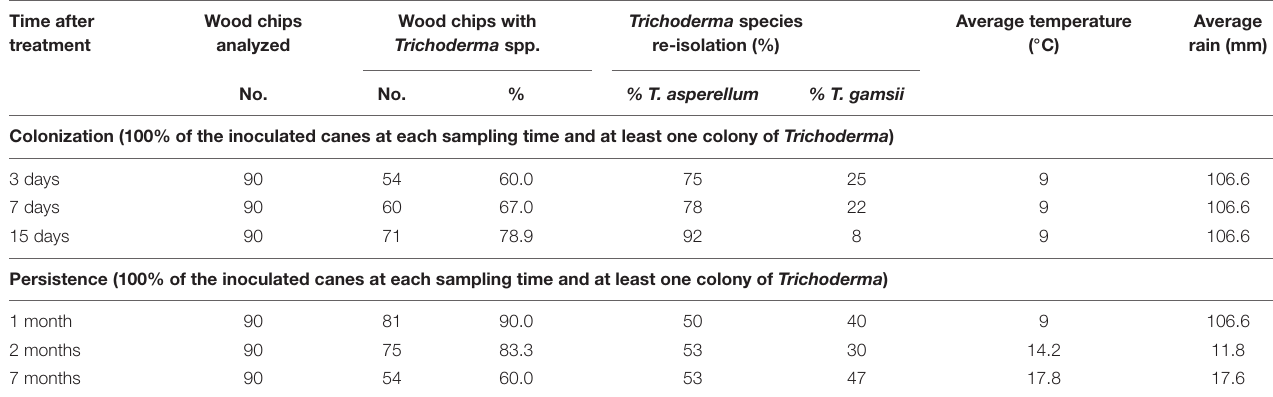
TABLE 5 | Persistence of the colonization of fresh pruning wounds over time of the Trichoderma species applied as a commercial formulation (Remedier R (cid:13) ). Time after treatment